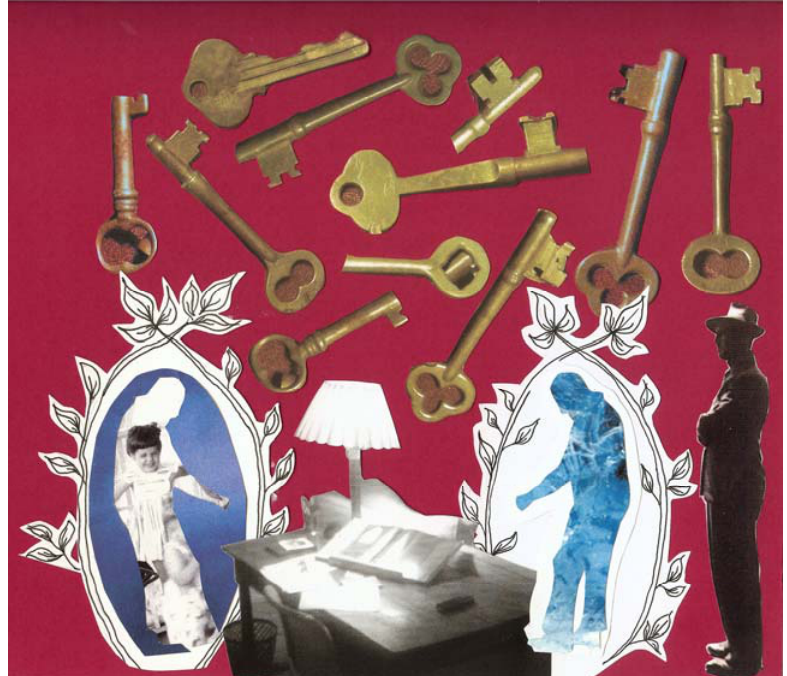
Figure 4. Collage with photographs of Joanna Clapps Herman and Peter Clapps, and keys collected for Peter’s first